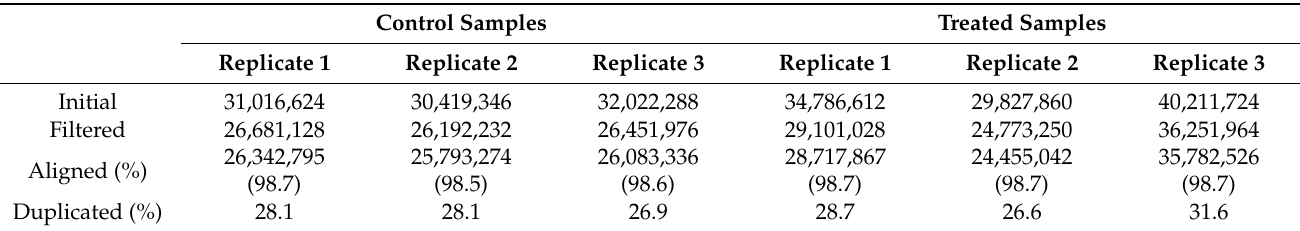
Table 2. Alignment of the sequences to the reference genome. This experiment was run with CdSe- QDs in parallel with the experiments with titanium dioxide and zinc oxide NPs and, therefore, shares the controls with the data published by Fuster and coworkers